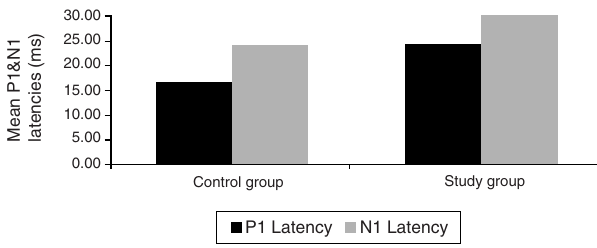
Comparison of mean P1 and N1 latencies of the study and control groups.